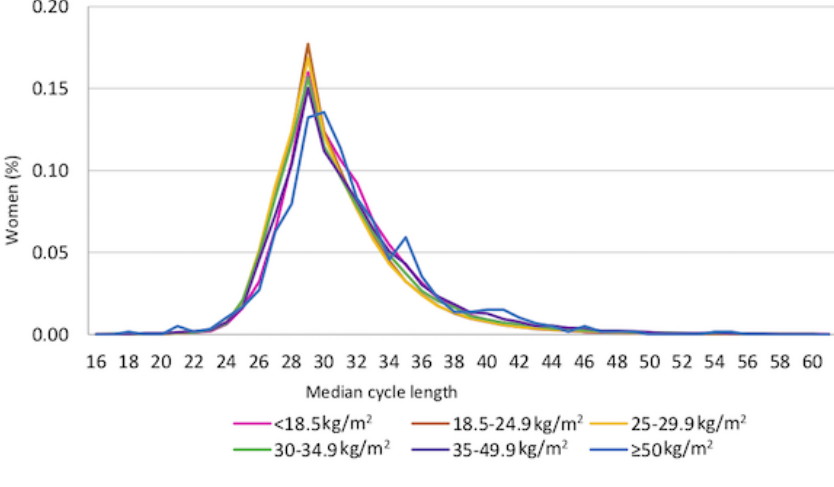
Figure 2. Median cycle length distribution by BMI categories.